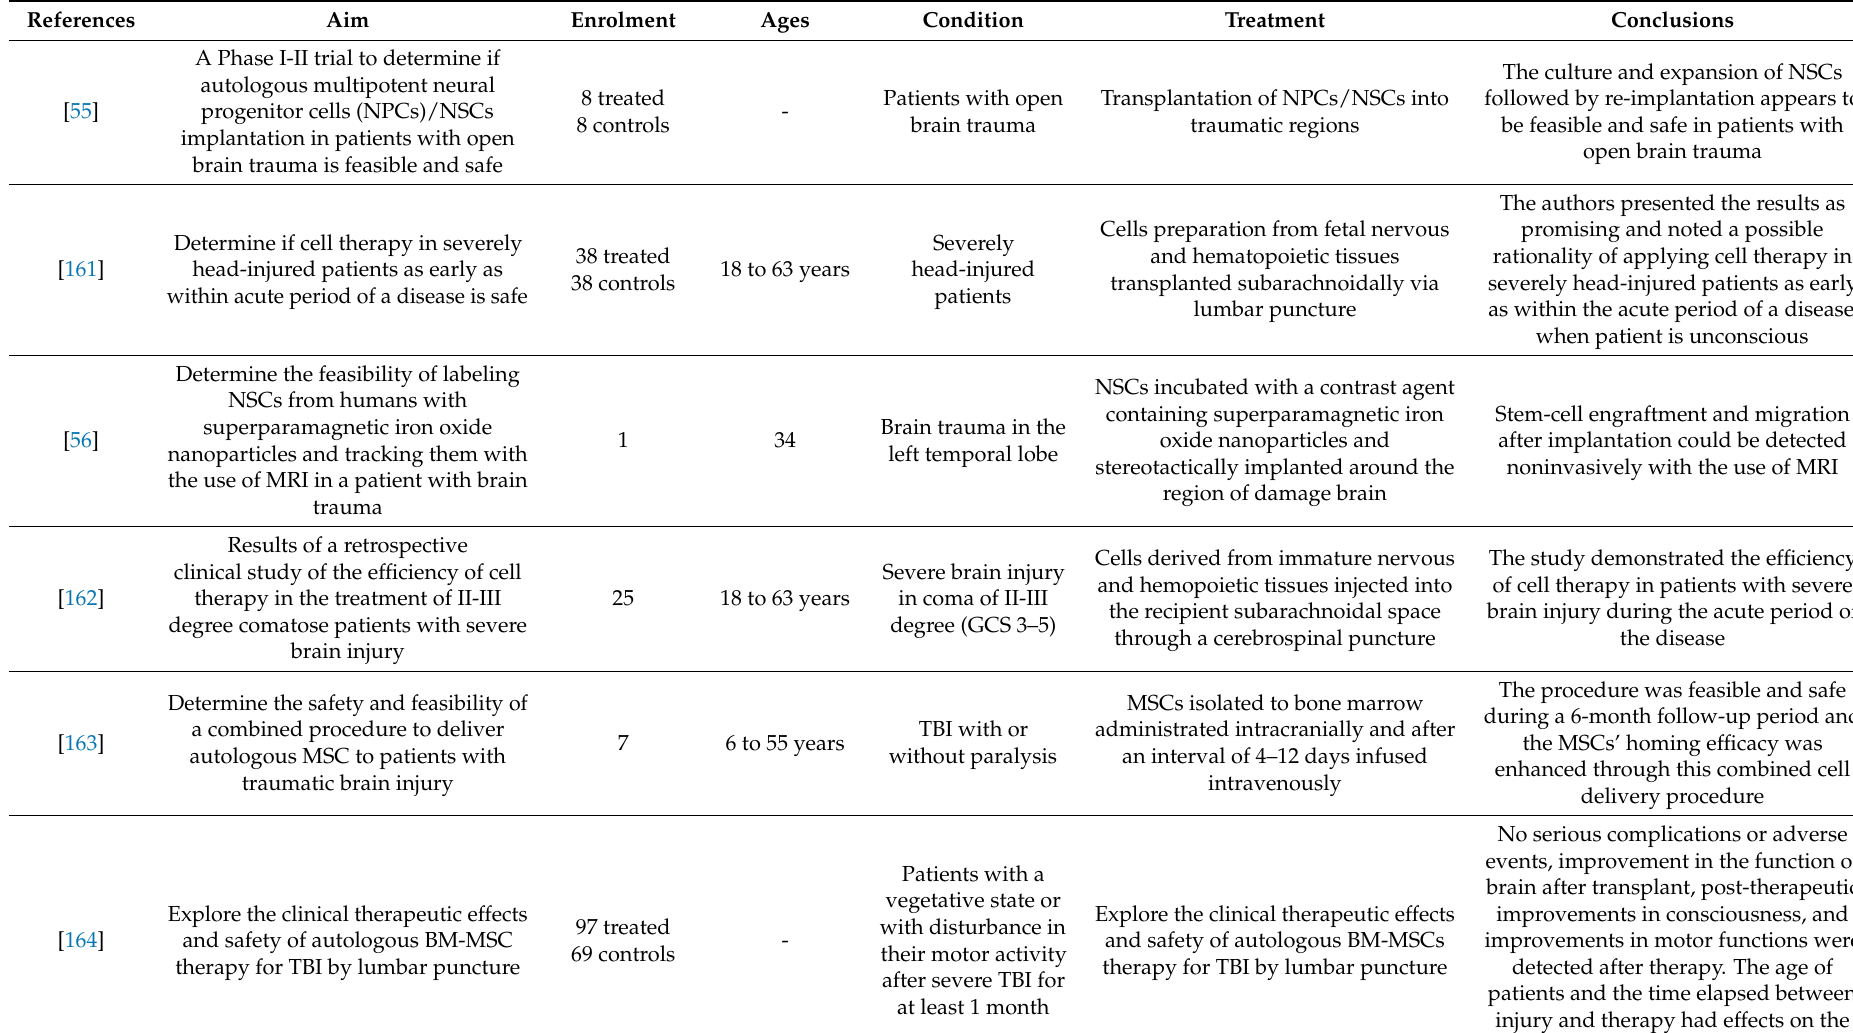
Table 3. Clinical trials approved by local ethics